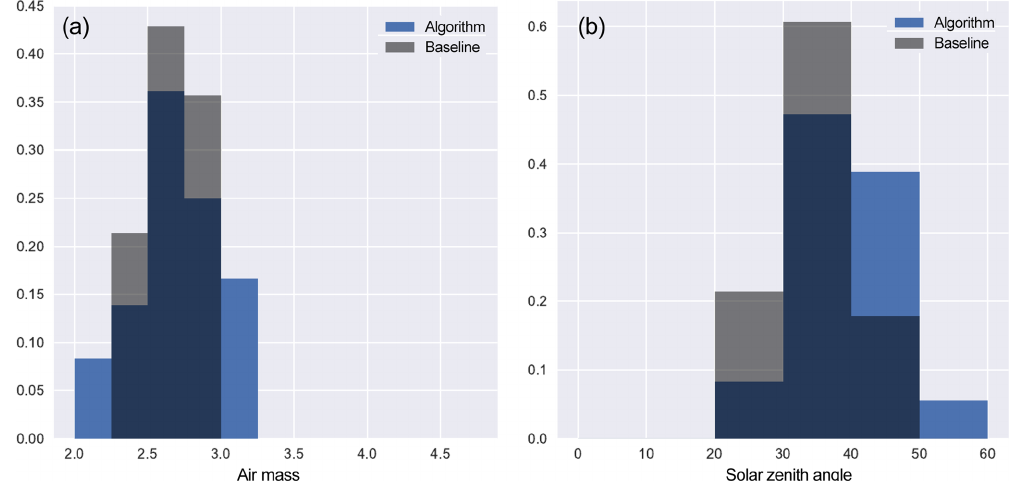
Figure 16. In the city campaign mode, the histograms show that the algorithm-selected strategy has more observations with low AF (a) , but the baseline strategy’s observations have lower SZA (b) . Table 2. The SRCs show that the variance and median of global error distributions are sensitive to starting AF